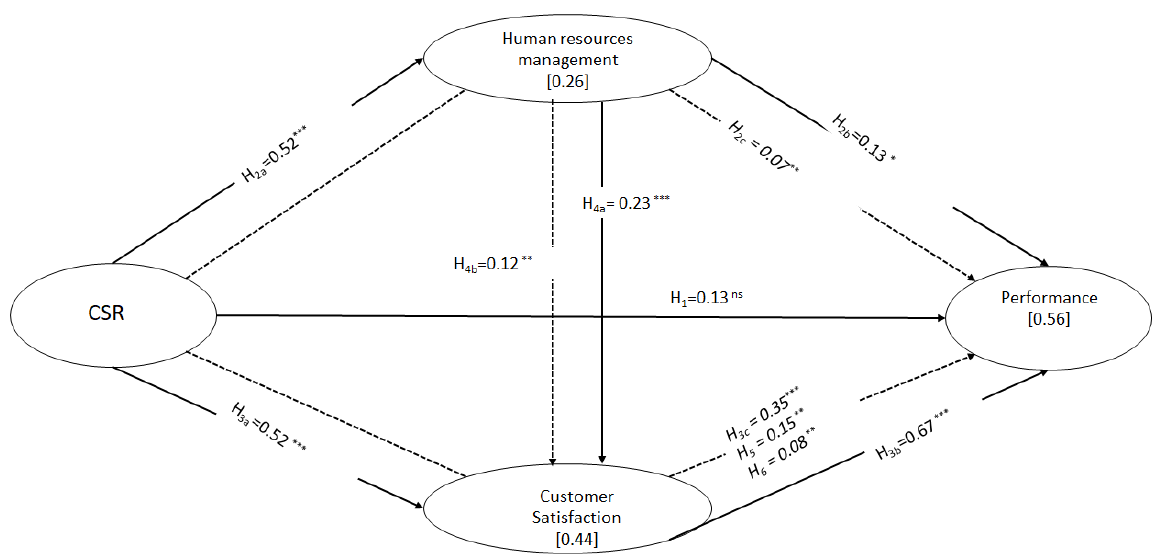
Figure 2. Results. *: p < 0.05; **: p < 0.01; ***: p < 0.001; ns: not significant. Source: Authors.